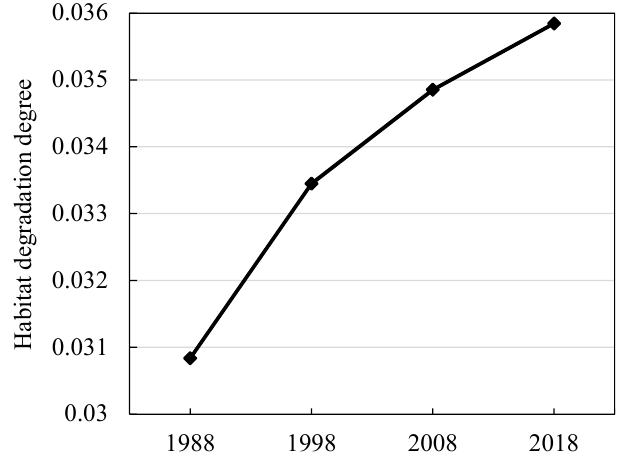
Figure 6. Habitat degradation degree in the PLEEZ from 1988 to 2018. di ff erent regions, we used NBC (natural break point classification) in ArcGIS to classify the degree of habitat degradation, which was divided into 5 levels: no degradation (0–0.025), mild